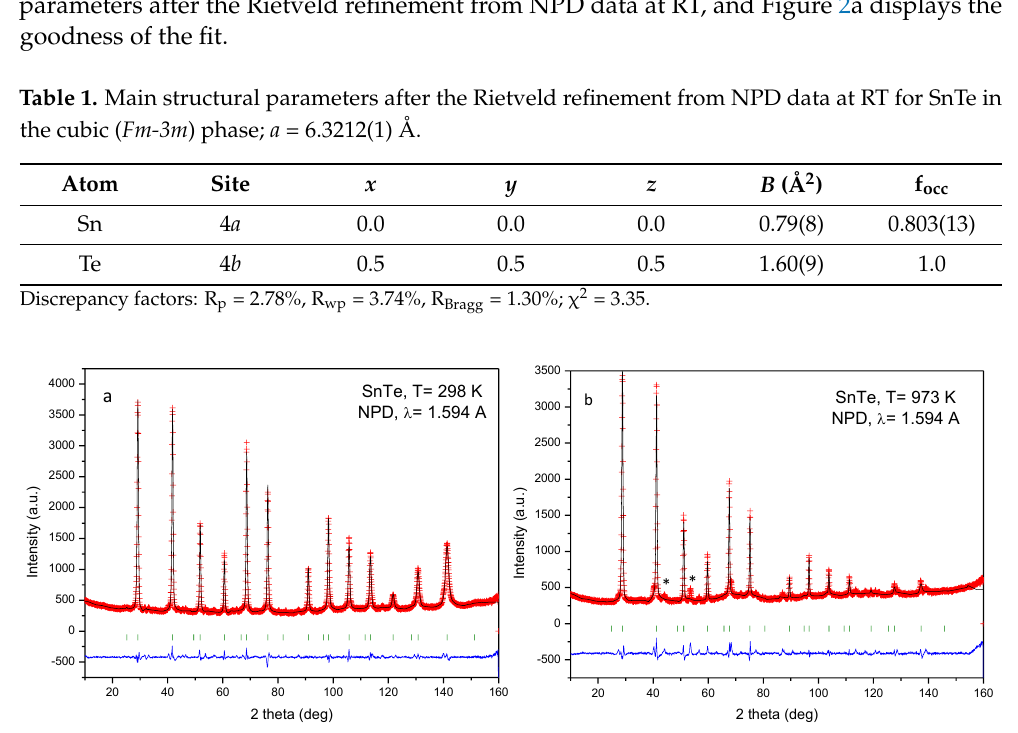
Figure 1. XRD pattern of SnTe from laboratory equipment, with Cu Kα radiation.